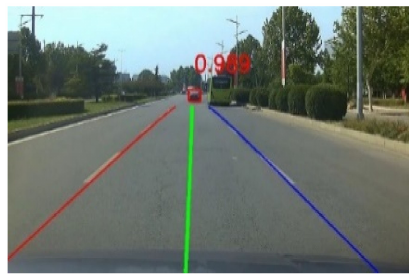
Figure 10. Vehicle and lane detection results of a frame.